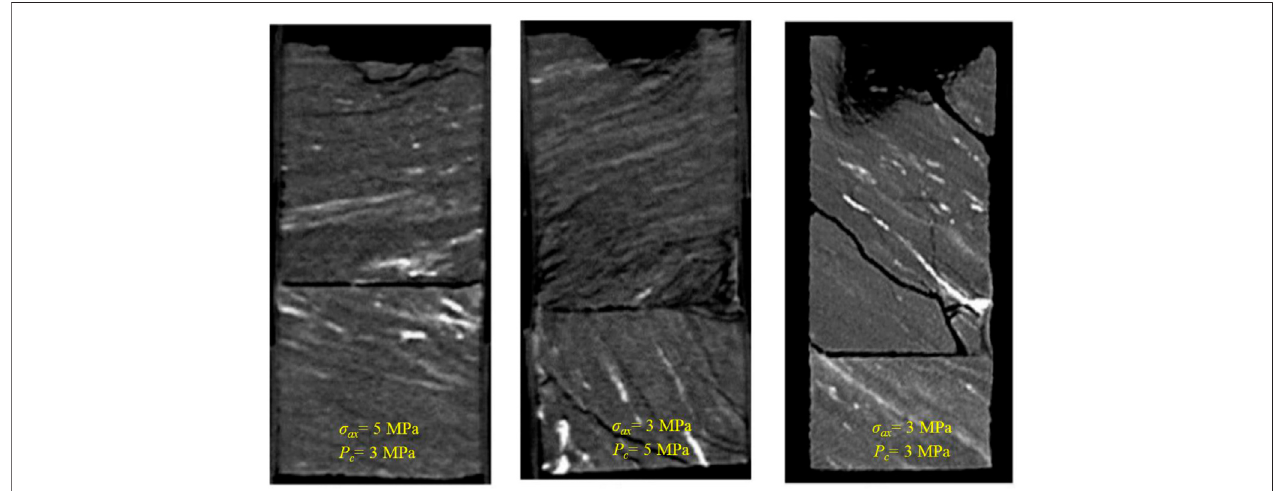
FIGURE 12 | CT (Computed Tomography) scanning images for the samples from the extra tests where the gas pressure is the same at 2.0 MPa, but the axial pressure and the con fi ning pressure acting on the sample are different.